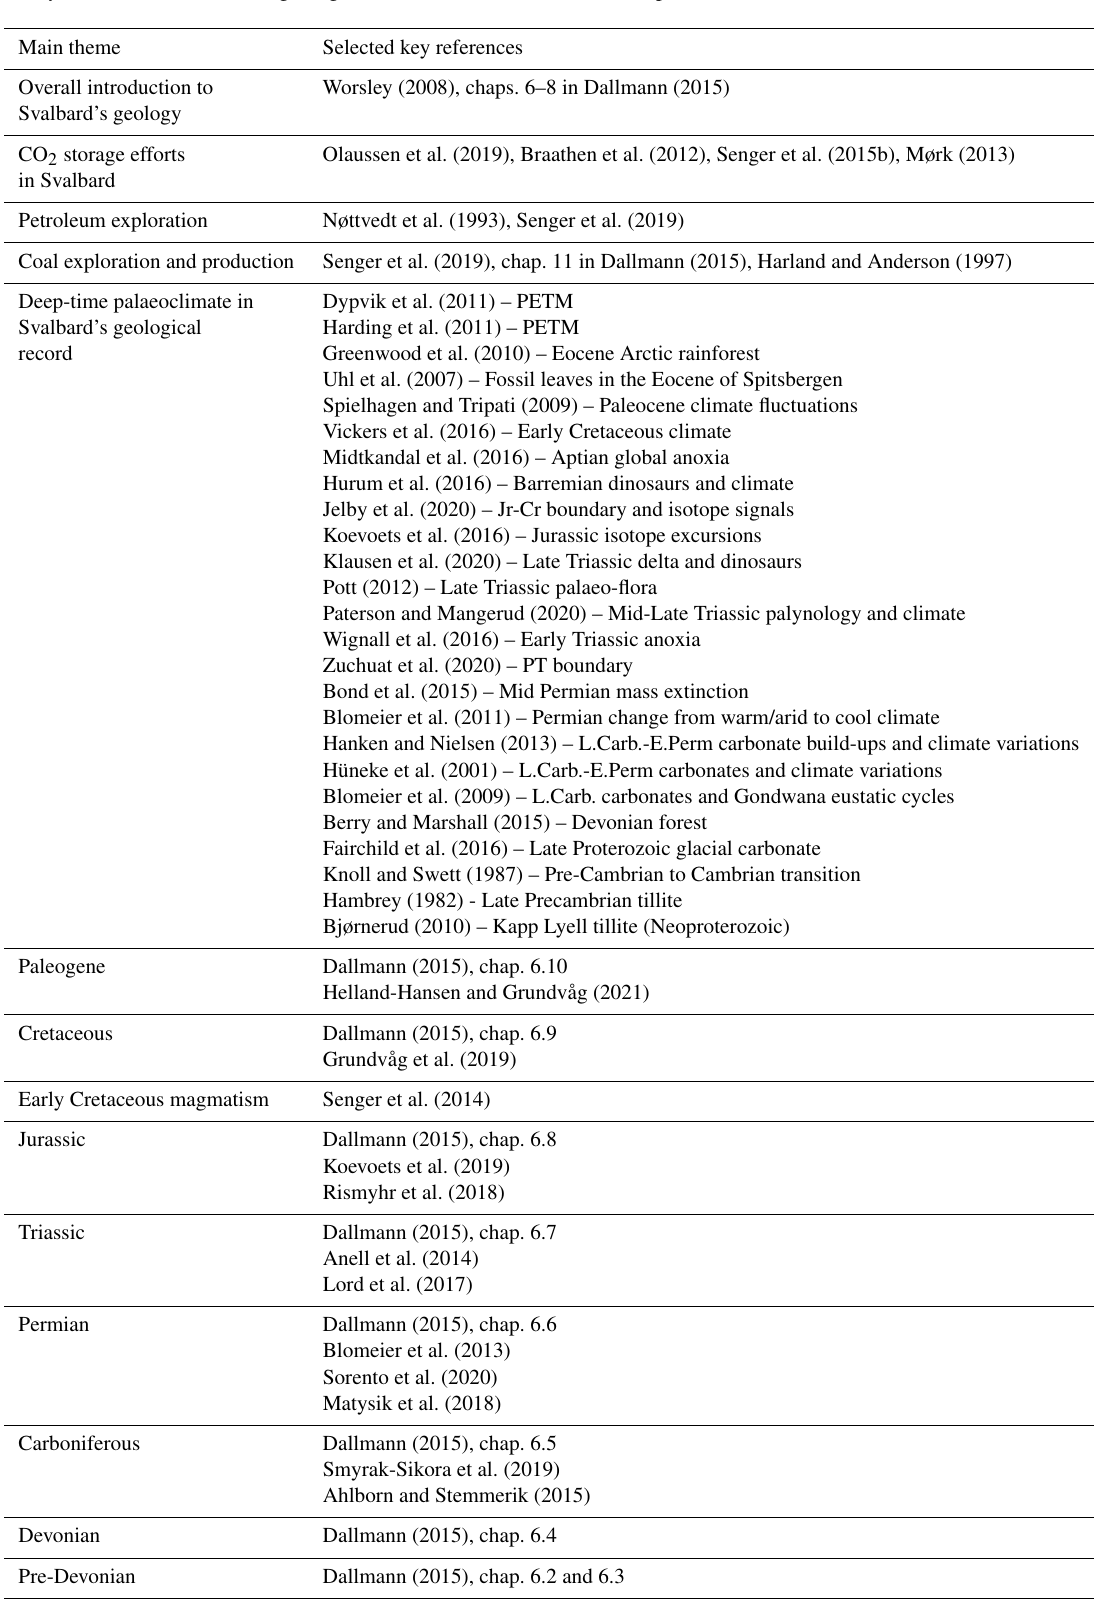
Table A2. Key literature on Svalbard’s geological evolution and main thematic